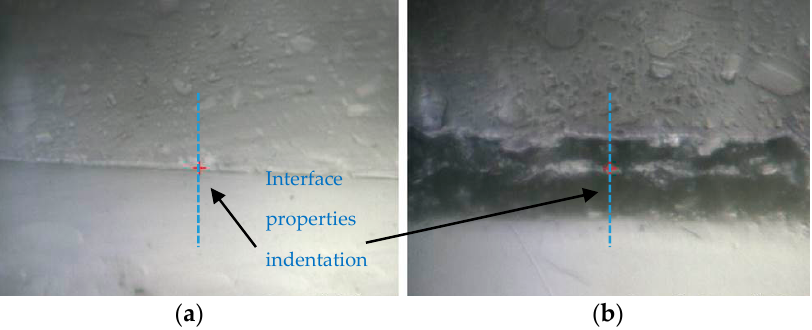
Figure 21. Layout of the indentation for measuring bulk properties of the gel coating and interphase properties of the two cases of curing. ( a ) Coat 1 (Cured) and ( b ) Coat 2 (Semi-cured).